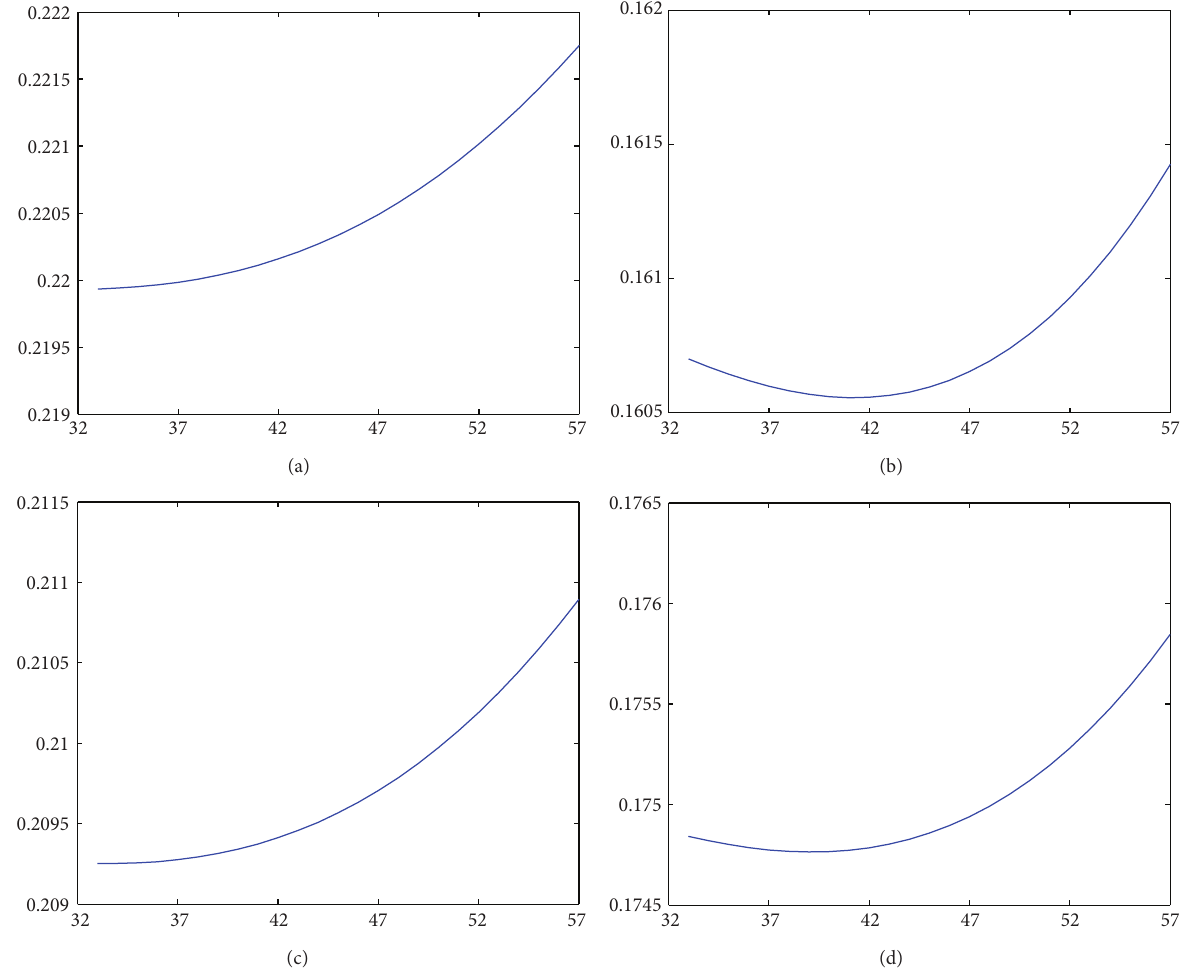
Figure 18: The phase angle from 32.9 degrees to 57.0 degrees of the spectrum of the “61,141” sample ( 𝑥 -axis is reduced reflectances and 𝑦 -axis is phase angle (degrees)).